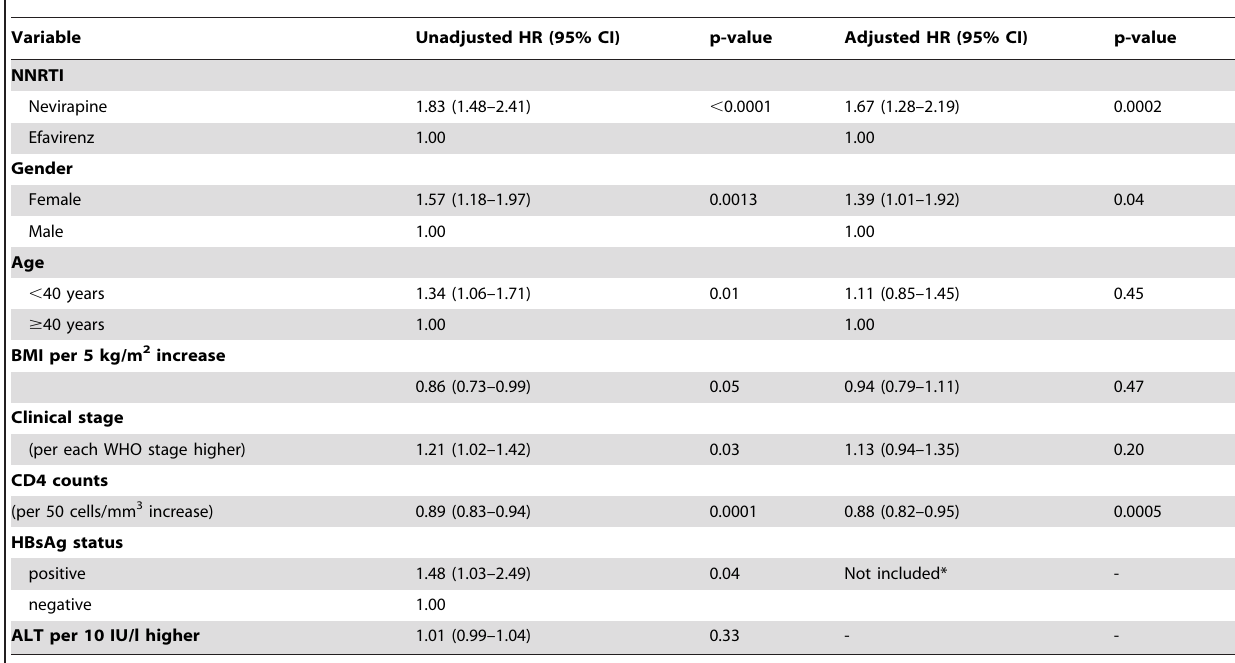
Table 3. Baseline risk factors associated with a NNRTI-related skin